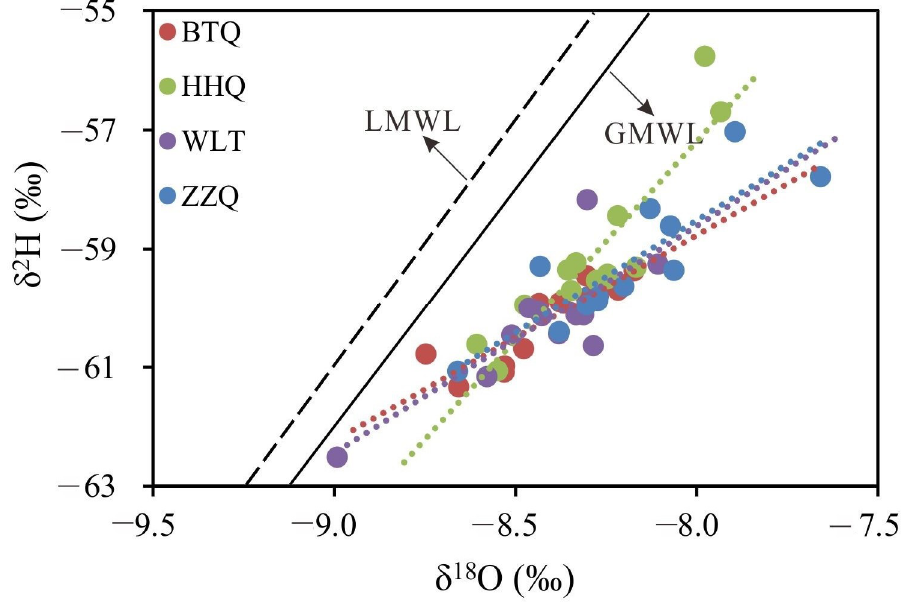
Figure 6. The relationship of δ 18 O and δ 2 H in spring samples from BTQ, HHQ, WLT, and ZZQ.